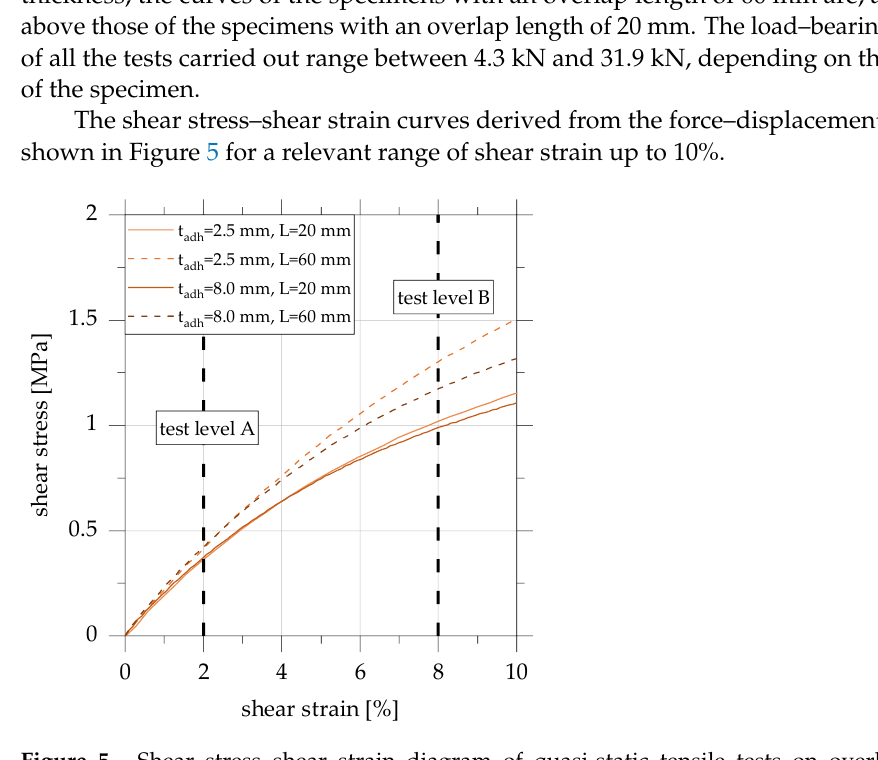
Figure 4. Machine force – machine displacement diagram of quasi-static tensile tests on overlap joints in accordance with [22].